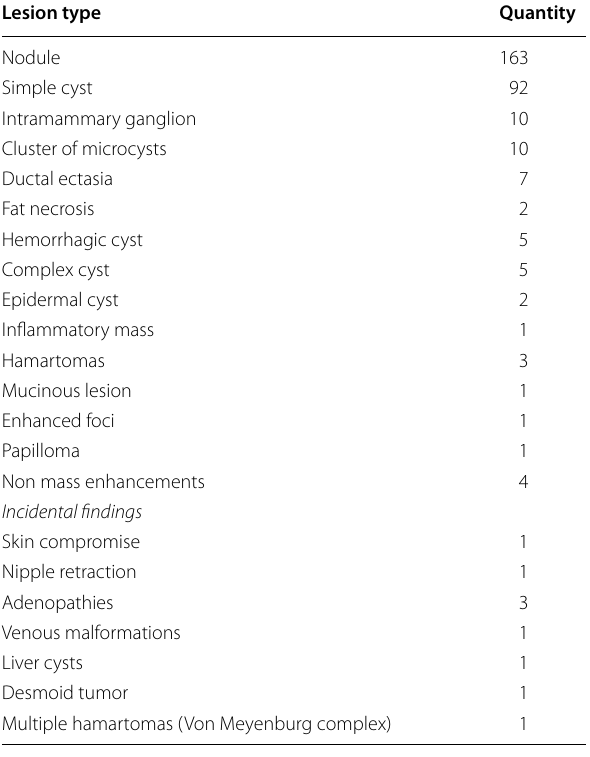
Table 4 Summary of findings reported at MRI